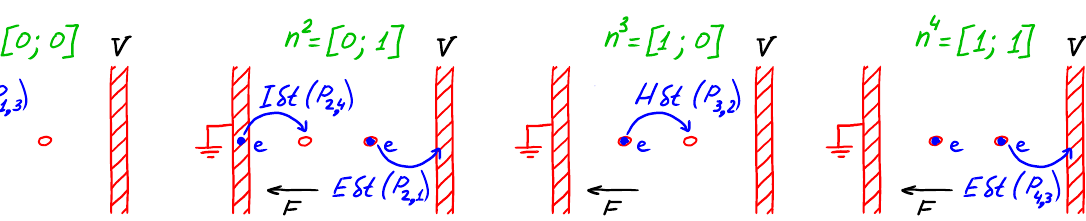
Figure 1. Illustration of sparsity of matrix (impossible transitions).